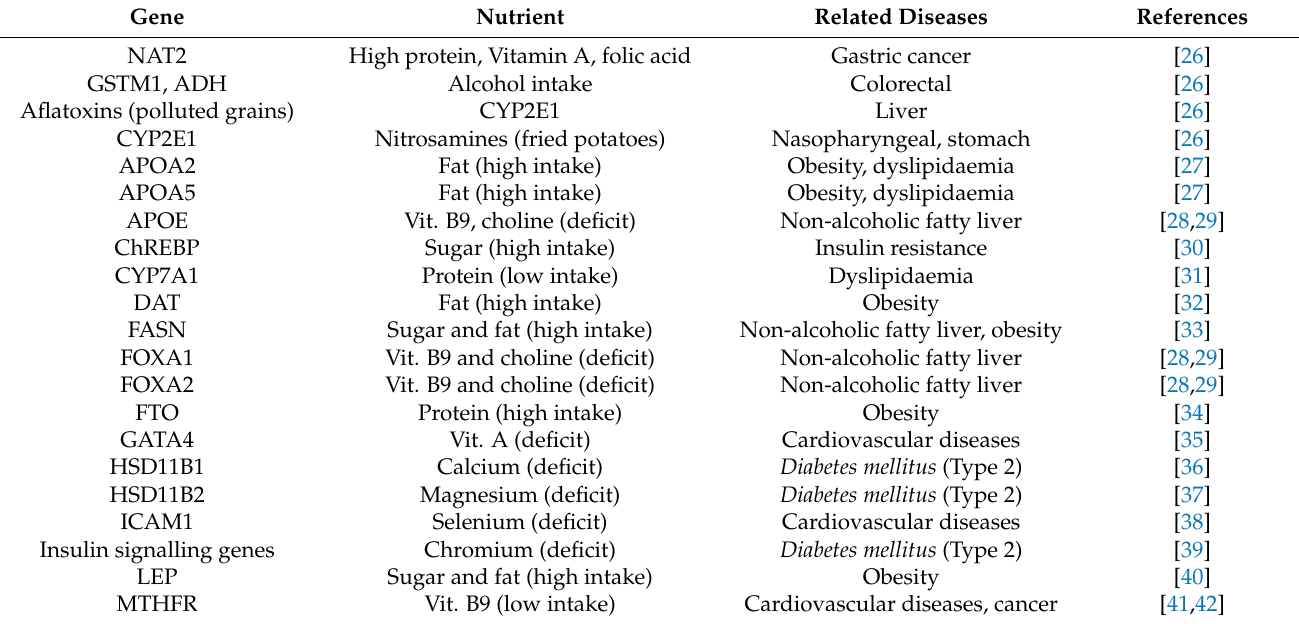
Table 1. Genes altered by nutrients and related